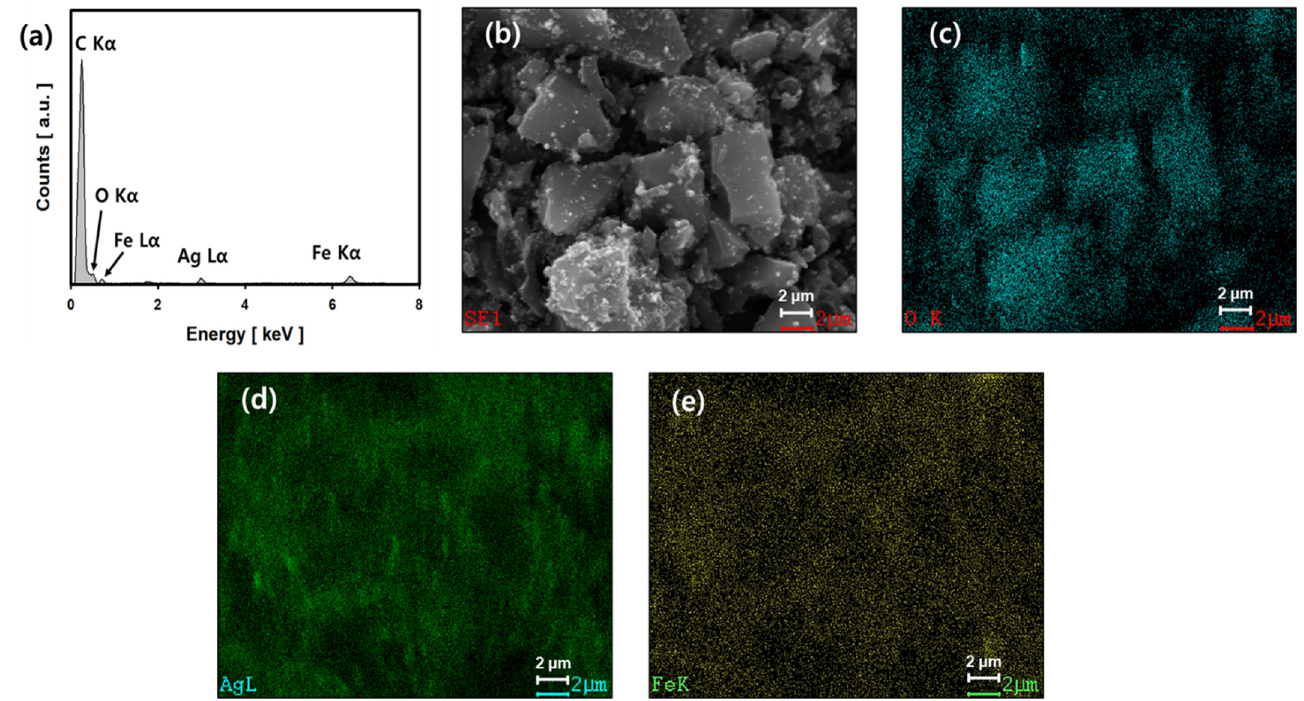
Figure 4. EDS spectrum ( a ), FE-SEM real image ( b ), oxygen ( c ), silver ( d ), and iron ( e ) elemental mapping result of SIACC prepared using the PLP method.